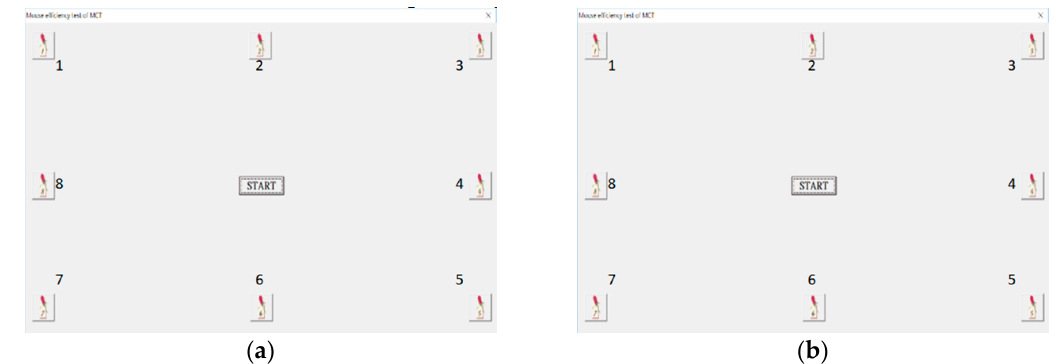
Figure 8. A mouse test interface for evaluating the efficiency of MCT ( a ) before the test and ( b ) after the test.